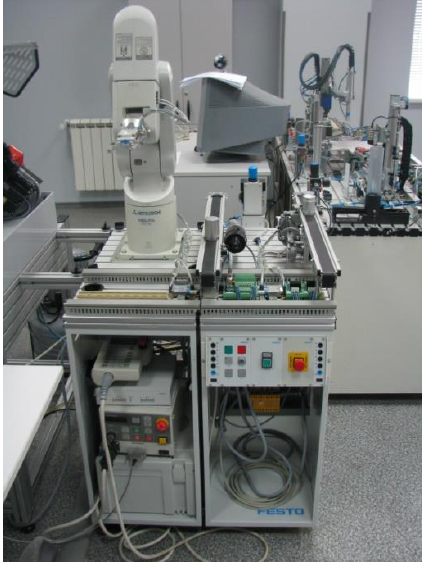
Figure 7. Industrial robot “Mitsubisi” with electric drives